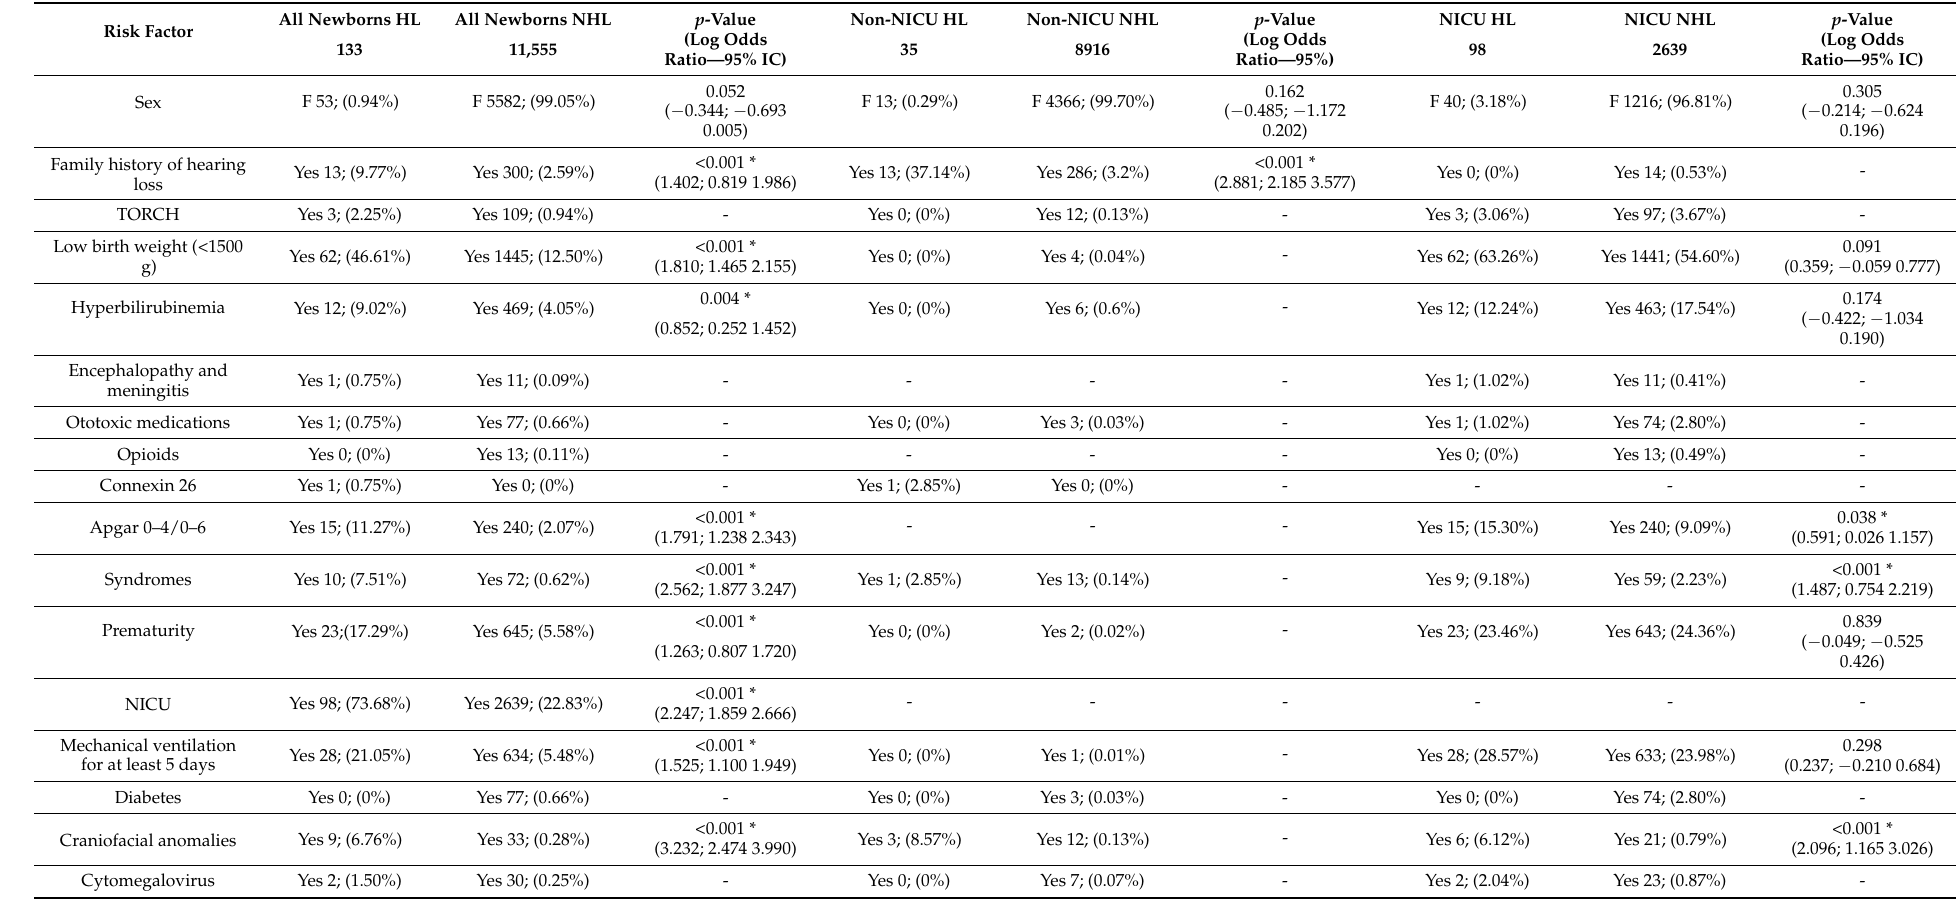
Table 3. Results of Pearson’s Chi-square test for contingency tables of risk factors and hearing loss status (any degree) in all newborns and in non-NICU and NICU newborns separately. Statistically significant values are marked with an asterisk *. Missing values (no events) and invalid tests are marked with a “-”. HL = hearing loss, NHL = no hearing